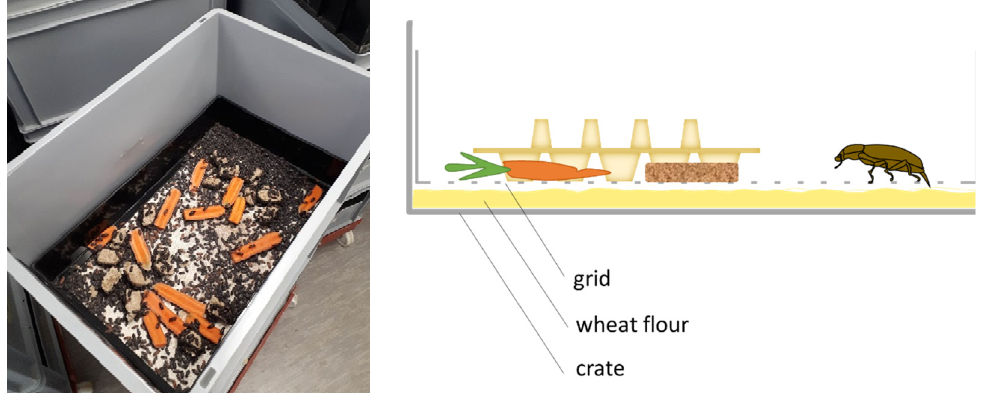
Figure 1. Photo and graphic representation of oviposition grid.